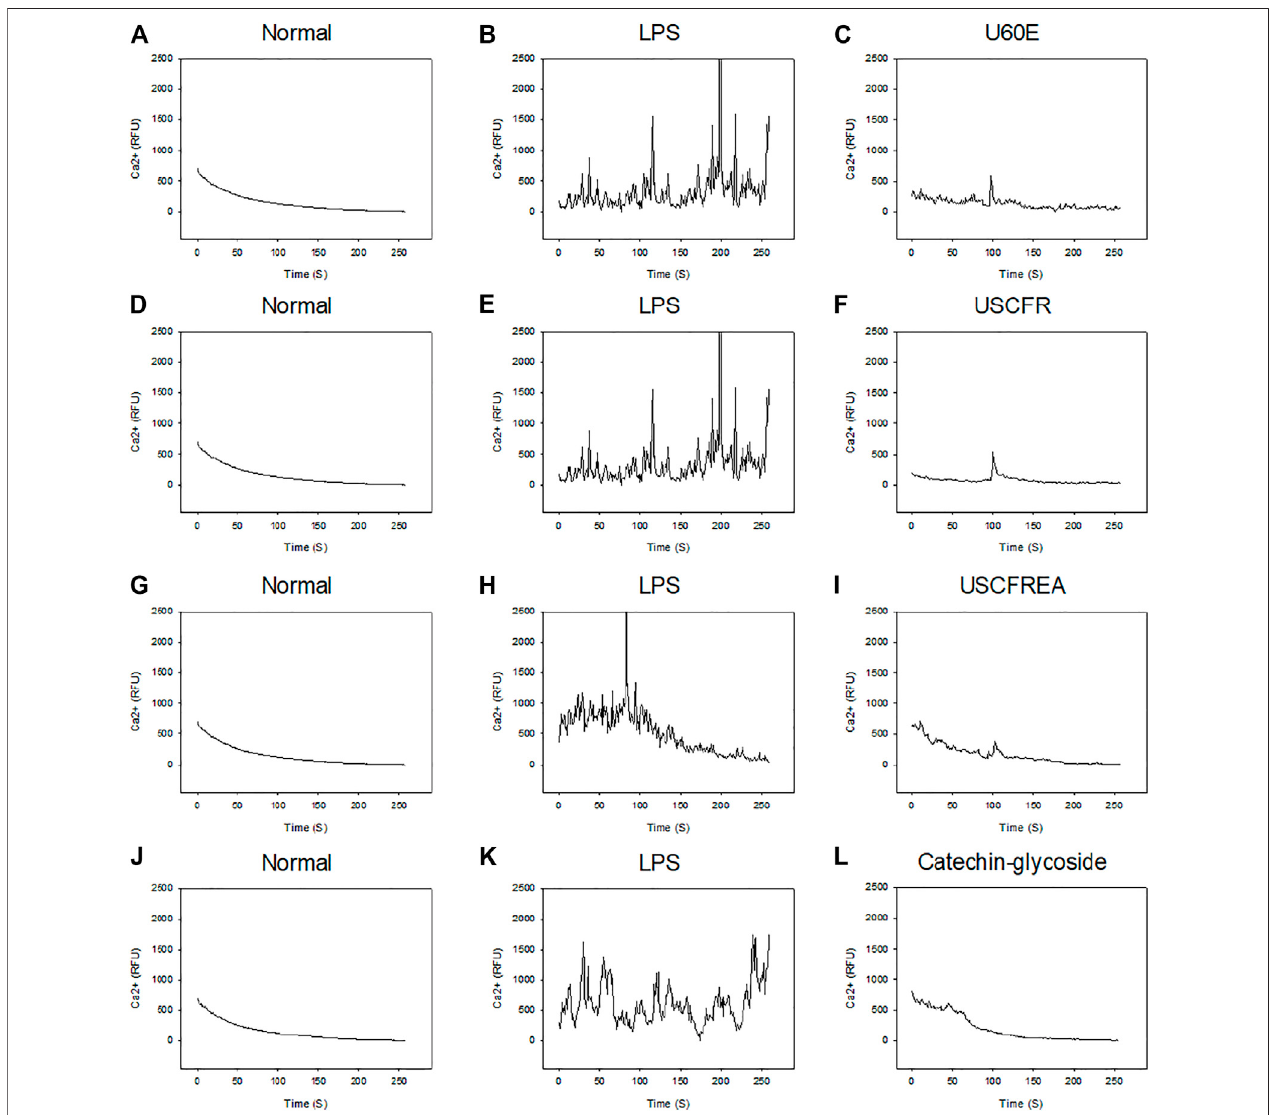
FIGURE 5 | LPS-induced Ca 2+ signaling and inhibition effects of U60E, USCFR, USCFREA, and catechin-glycoside – rich fraction. Cells were plated on confocal dishes and loaded with Ca 2+ -speci fi c dye as detailed in Materials and Methods. LPS (1 μ g/ml) was added and Ca 2+ mobilization was monitored at the indicated time points. Normal (A,D,G,J) and LPS (B,E,H,K) . (C) U60E, (F) USCFREA, (I) USCFR, and (L) catechin-glycoside – rich fraction (each 50 μ g/ml) were pretreated for 10 min before LPS treatment. Data are representative of three independent experiments and values are expressed.